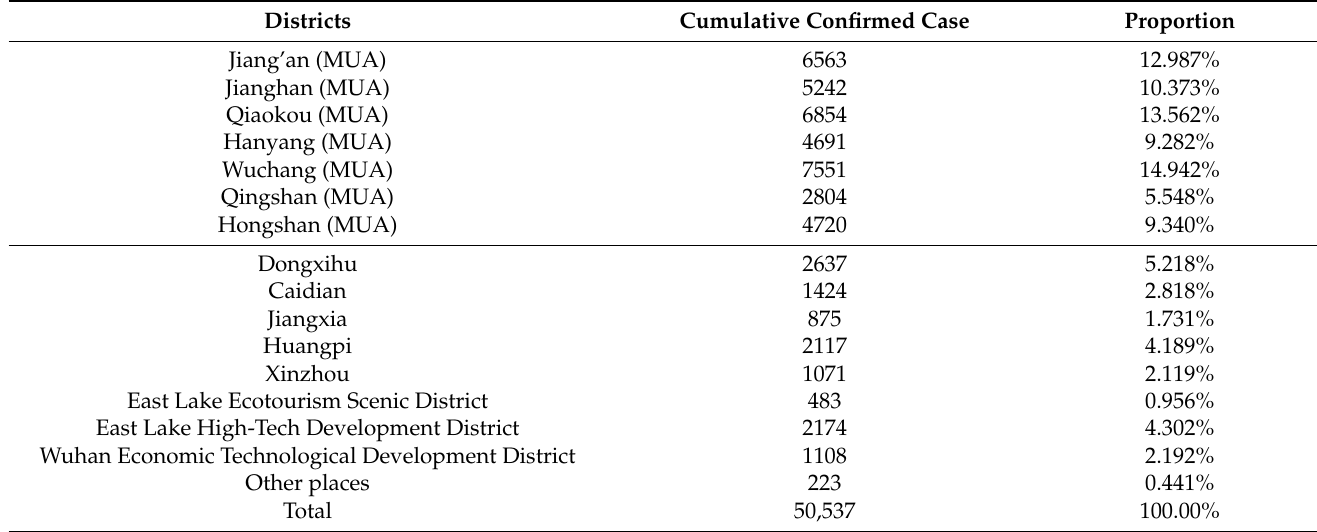
Table 1. Case statistics of Wuhan.